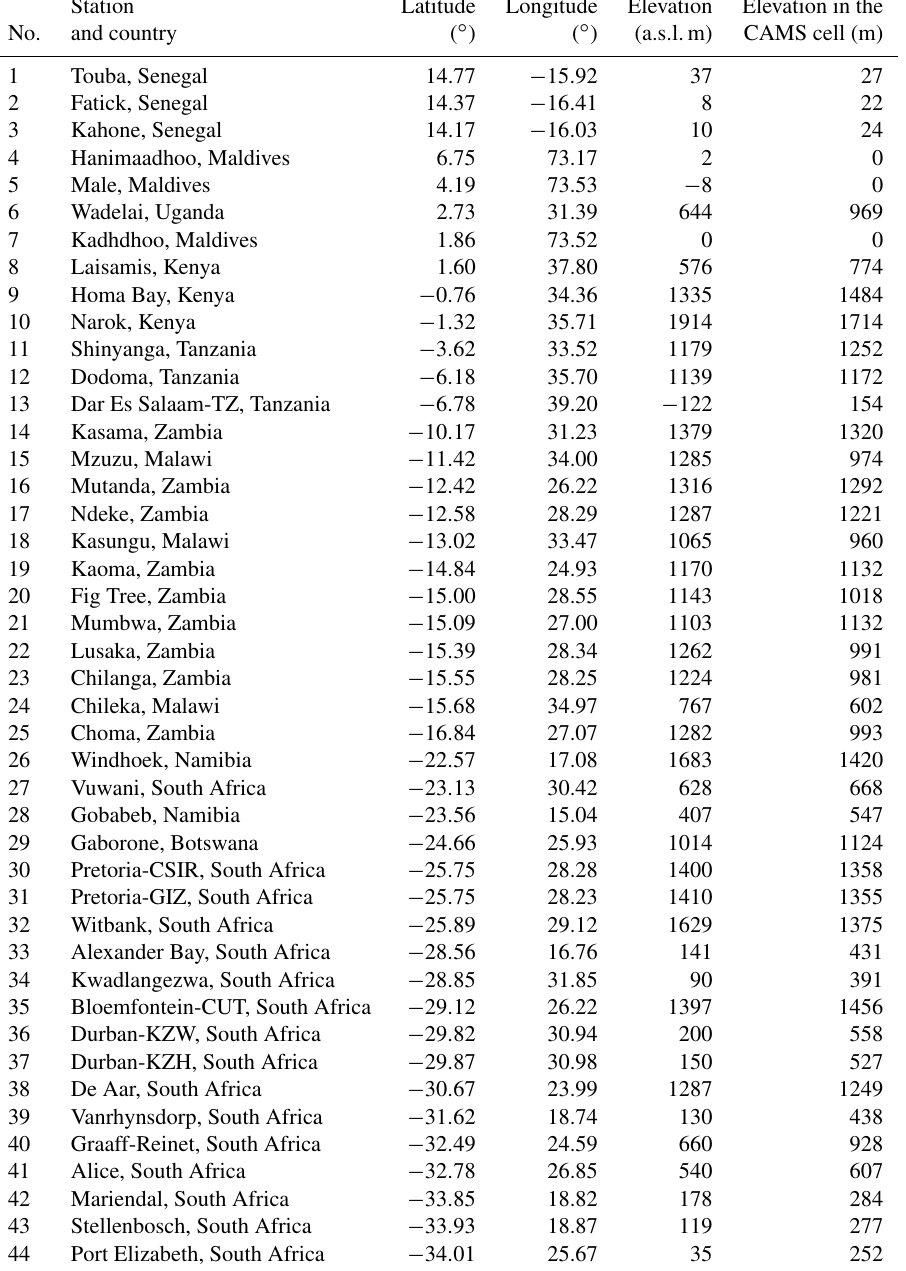
Table 1. Description of measuring stations used for validation, ordered by decreasing latitude.